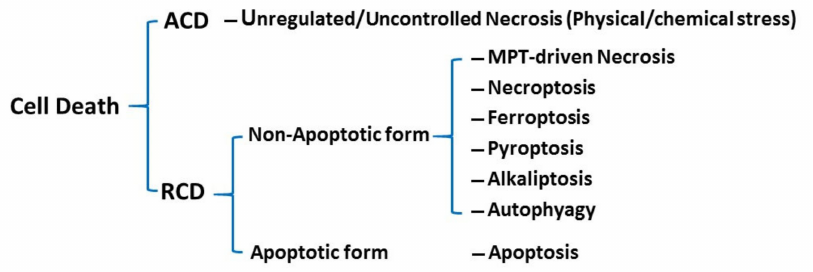
Figure 1. Classification of cell death. ACD: accidental cell death; RCD: regulated cell death; MPT: mitochondrial permeability transition